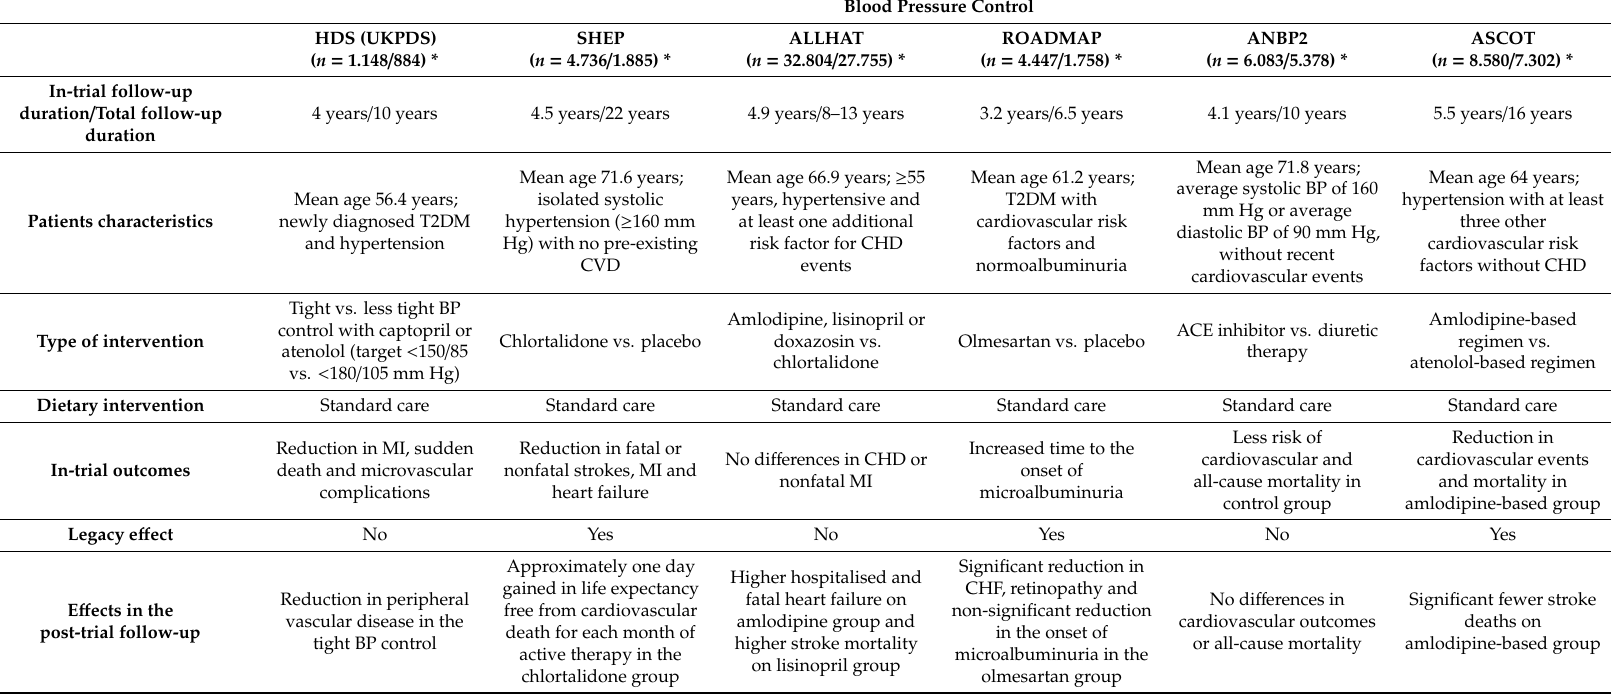
Table 2. Studies assessing the legacy e ff ect after intensive BP